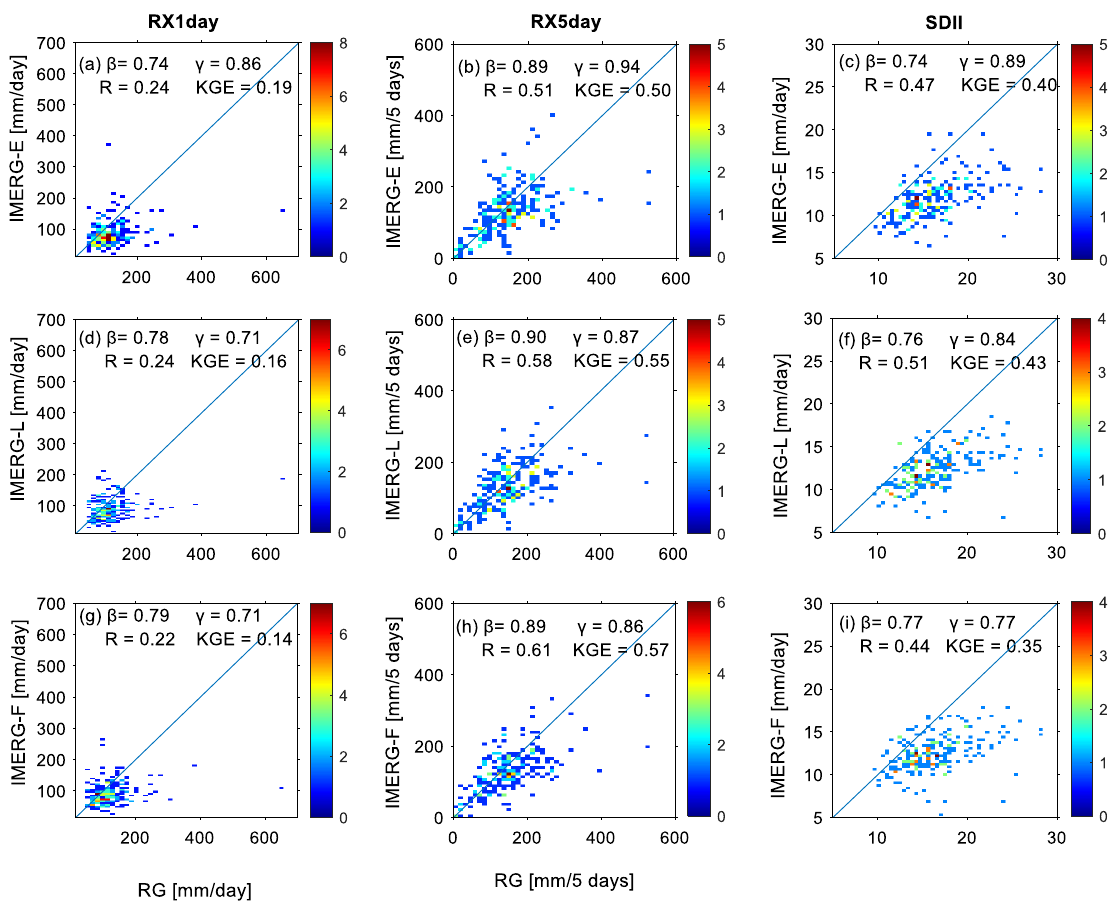
Figure 10. Scatter plot of precipitation-intensity-based indices from IMERG and RG observation, namely, RX1day ( a , d , g ), RX5day ( b , e , h ), and SDII ( c , f , i ), for IMERG-E (top), L (middle) and F (bottom). The color indicates the number of data counts.